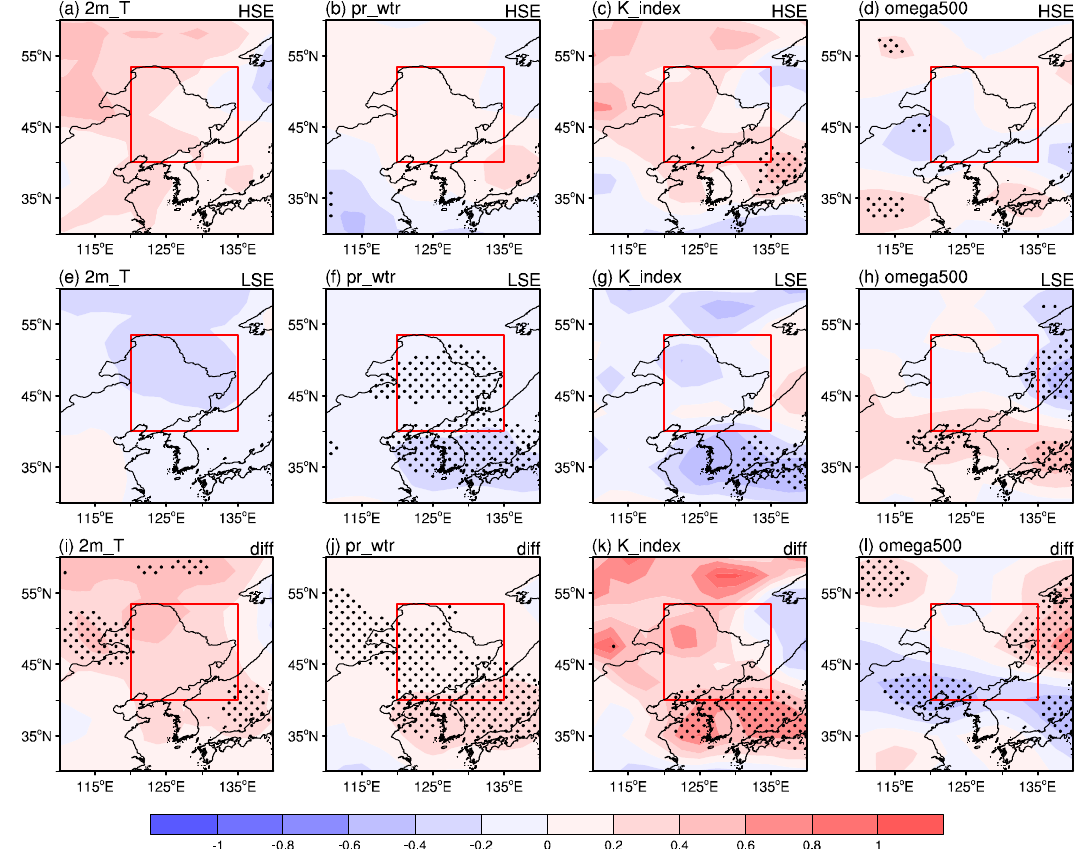
Figure 8. Composite differences in the climatic elements field for the composite of more HSE years and more LSE years in wintertime over NEC: ( a – d ) 2-m air temperature (units: °C ), precipitable water (units: kg m − 2 ), K-index (units: K), and 500-hPa vertical velocity (units: 10 − 2 Pa s − 1 ) in the composite of more HSE years, respectively; ( e – h ) as in ( a – d ) but for the composite of more LSE years; ( i – l ) as in ( a – d ) but for the difference between the composite of more HSE years and that of more LSE years. Stippling denotes where the anomalies are significant at the 90% confidence level.